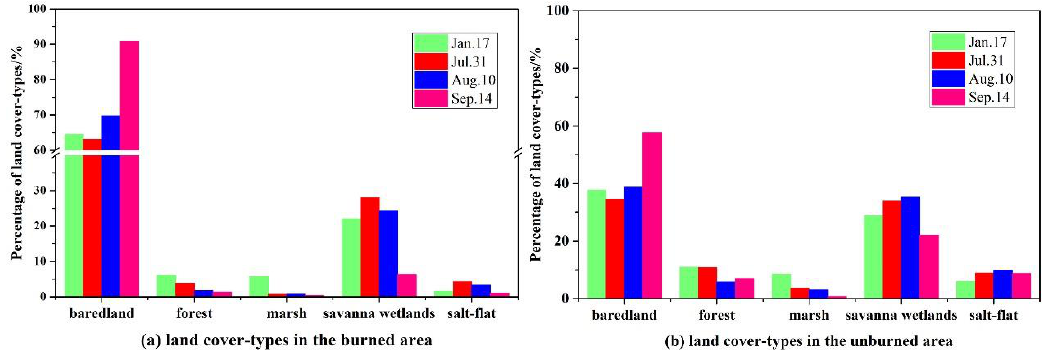
Figure 6. The percentage of wetland/non-wetland types: ( a ) land-cover types in the maximum burn range of the fire; ( b ) land-cover types in the unburned area.